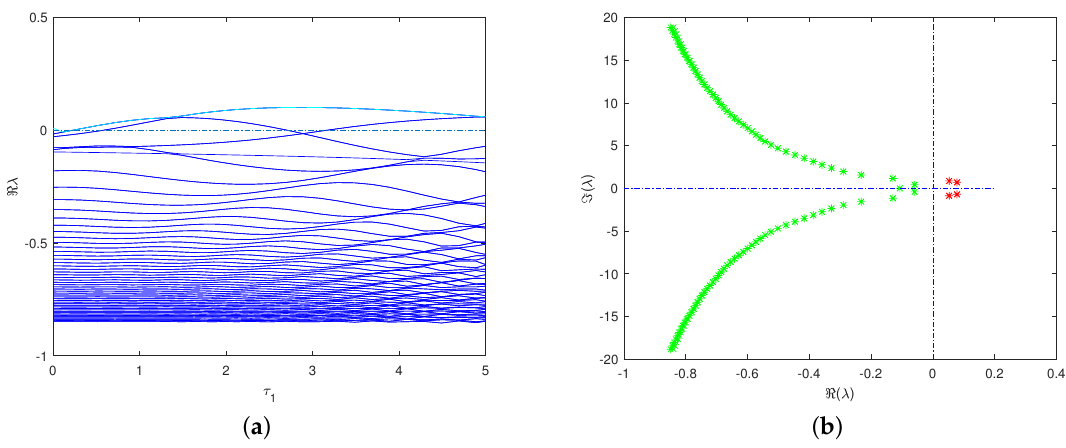
Figure 3. When τ 2 = 8, ( a ) the eigenvalue diagram of the system for τ 1 kept changing, and ( b ) shows the eigenvalue sketch diagram of the system for τ 1 =